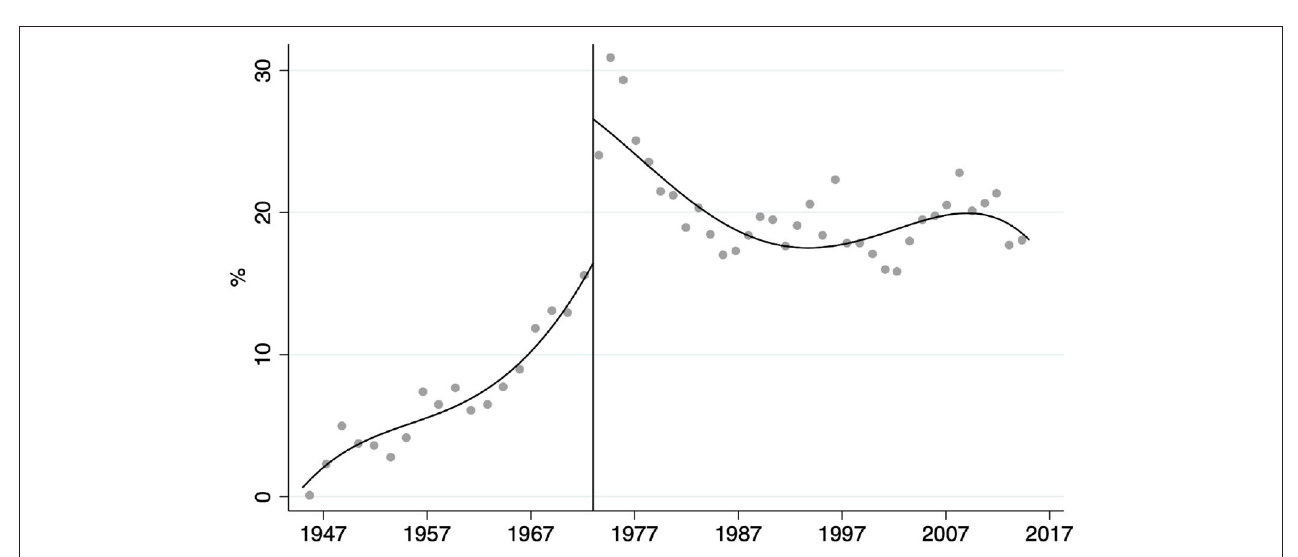
FIGURE 2 | Total number of teams by Division (per season).